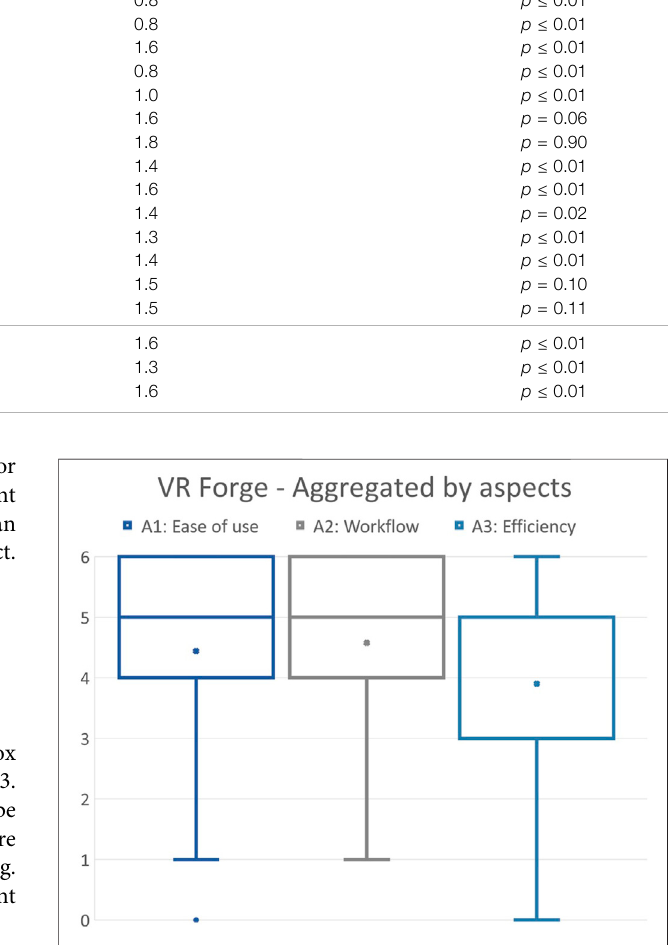
FIGURE 9 | Box and whisker plots aggregated by the three aspects A1 –